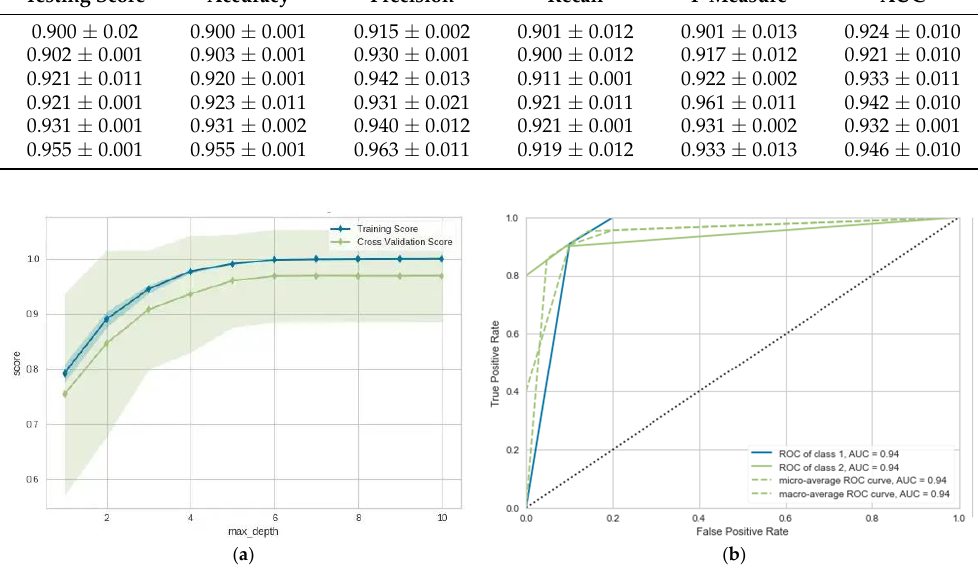
Figure 4. ( a ) Learning curve for the proposed model; ( b ) validation curve for proposed model (di- agnosis model).